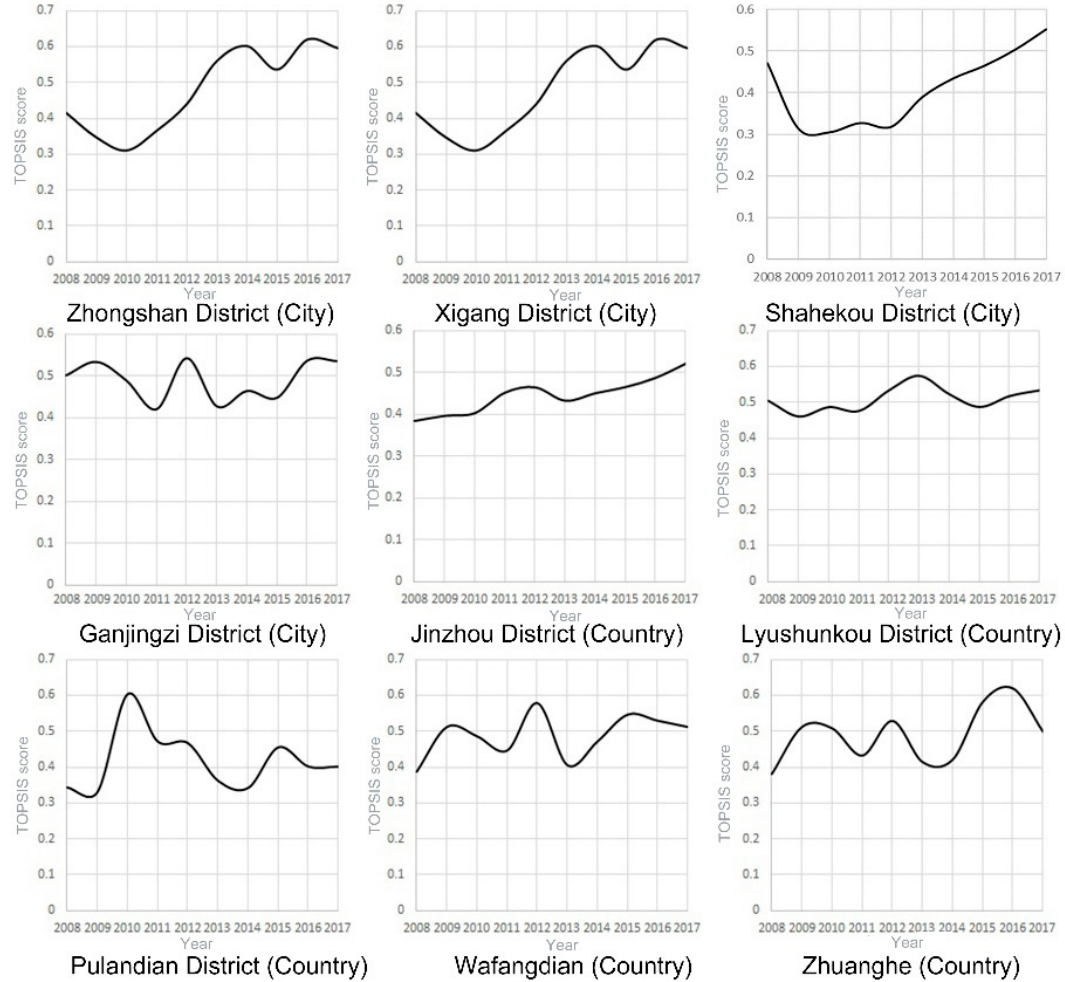
Figure 1. 2007–2018, Dalian urban and rural technique for order preference by similarity to ideal solution (TOPSIS) curve. Int. J. Environ. Res. Public Health 2020 , 17 , x